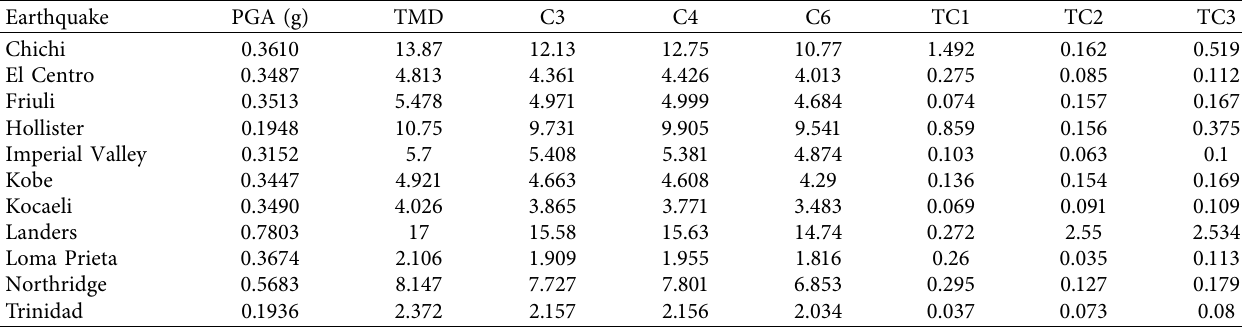
Table 2: Root mean square of generalized displacement with different earthquakes and different structures installed, unit ( × 10 − 3 m). Earthquake PGA (g)